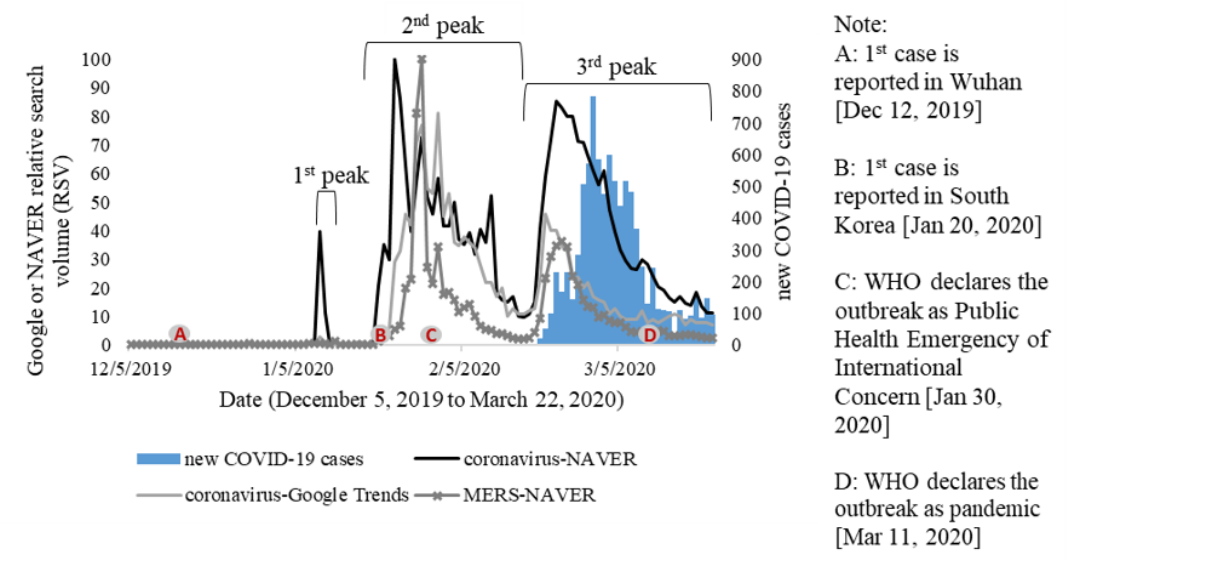
Figure 2. Time series of new COVID-19 cases and Google Trends and NAVER relative search volumes related to the coronavirus and MERS in South Korea. MERS: Middle East respiratory syndrome; WHO: World Health Organization.